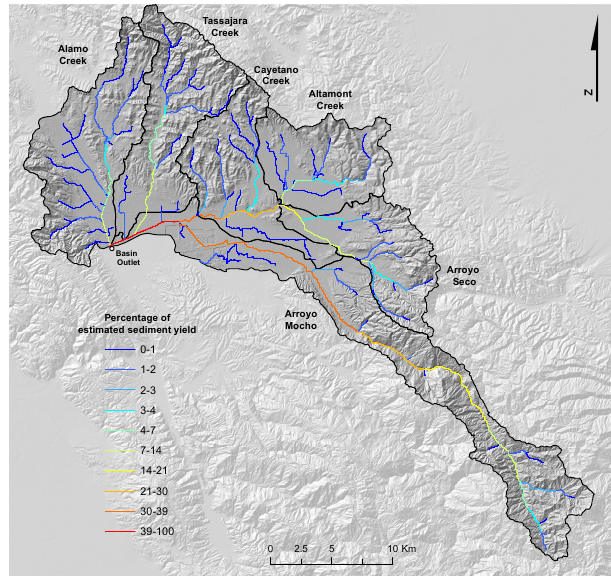
Figure 8. Estimated specific sediment yield aggregated down through the stream network for mainstem streams (draining ar- eas>2km 2 ).